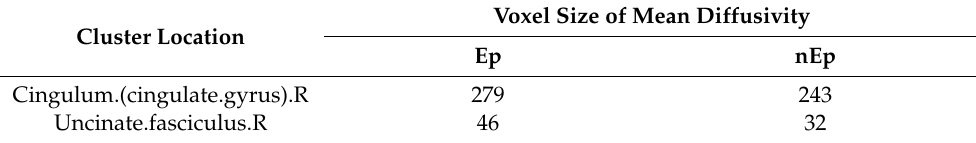
Table 4. Significant clusters of mean